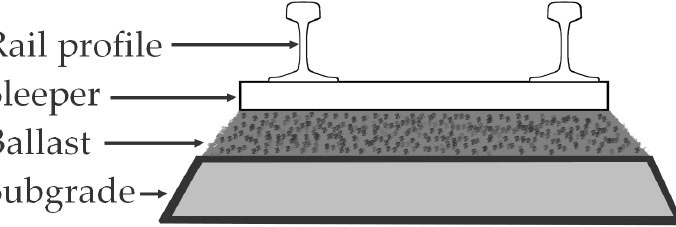
Figure 1. Scheme of railway subgrade elements.